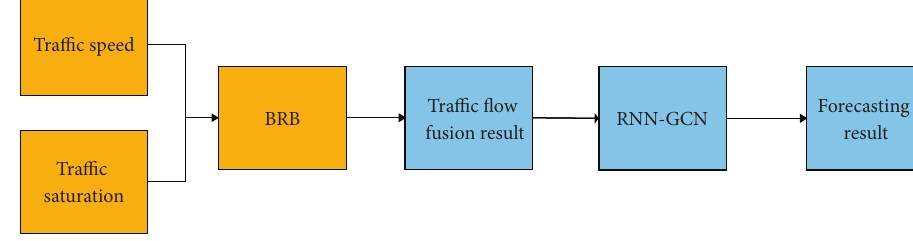
Figure 9: Traffic flow prediction process. . 1